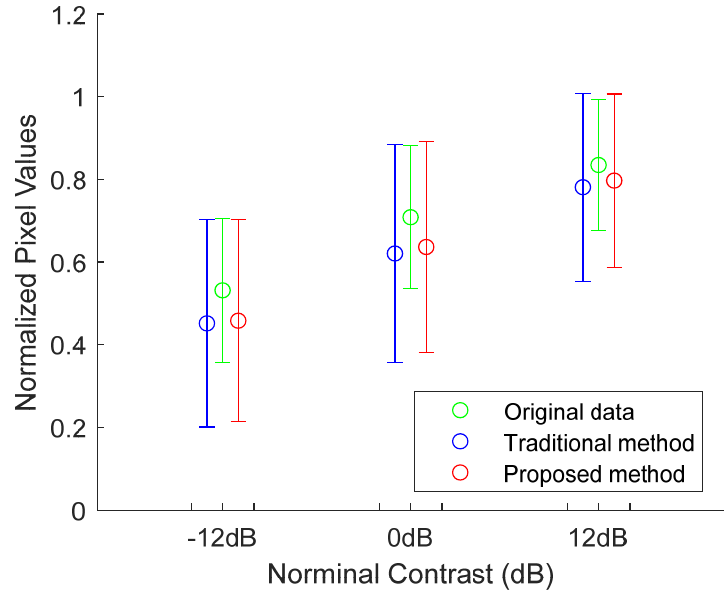
Figure 6. Results of B-mode pixel values of the original data and the reconstructed CS data using traditional and the proposed methods for three contrast TM phantoms of the 70% compression.